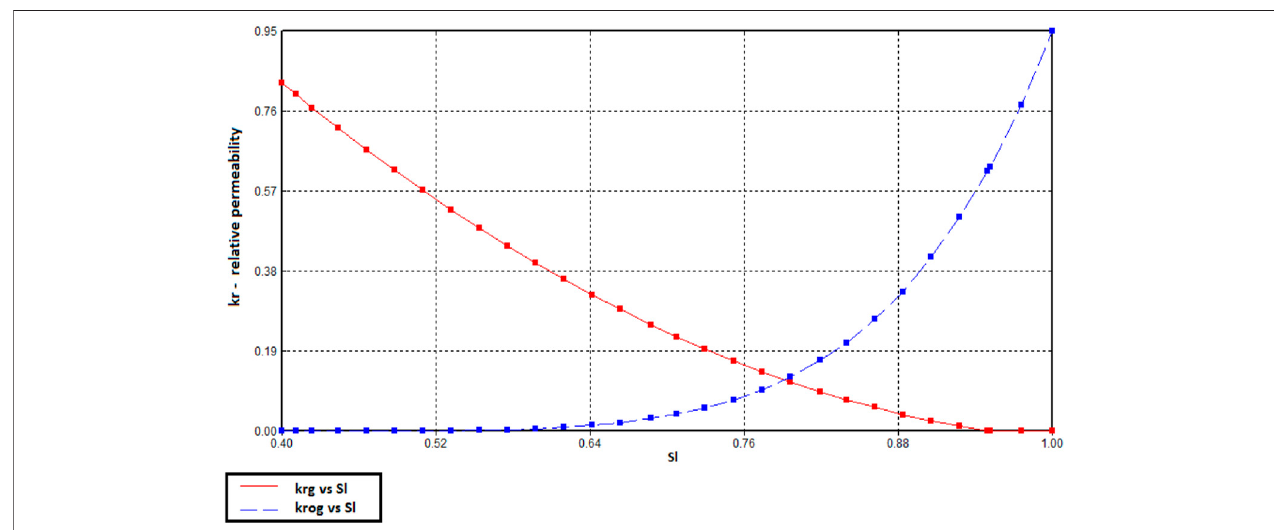
FIGURE 3 | Gas and oil relative permeability curves as a function of gas saturation.